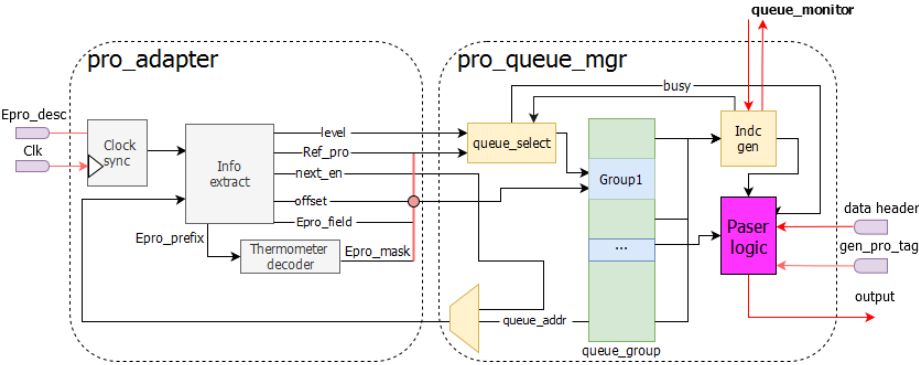
Figure 5. Protocol update